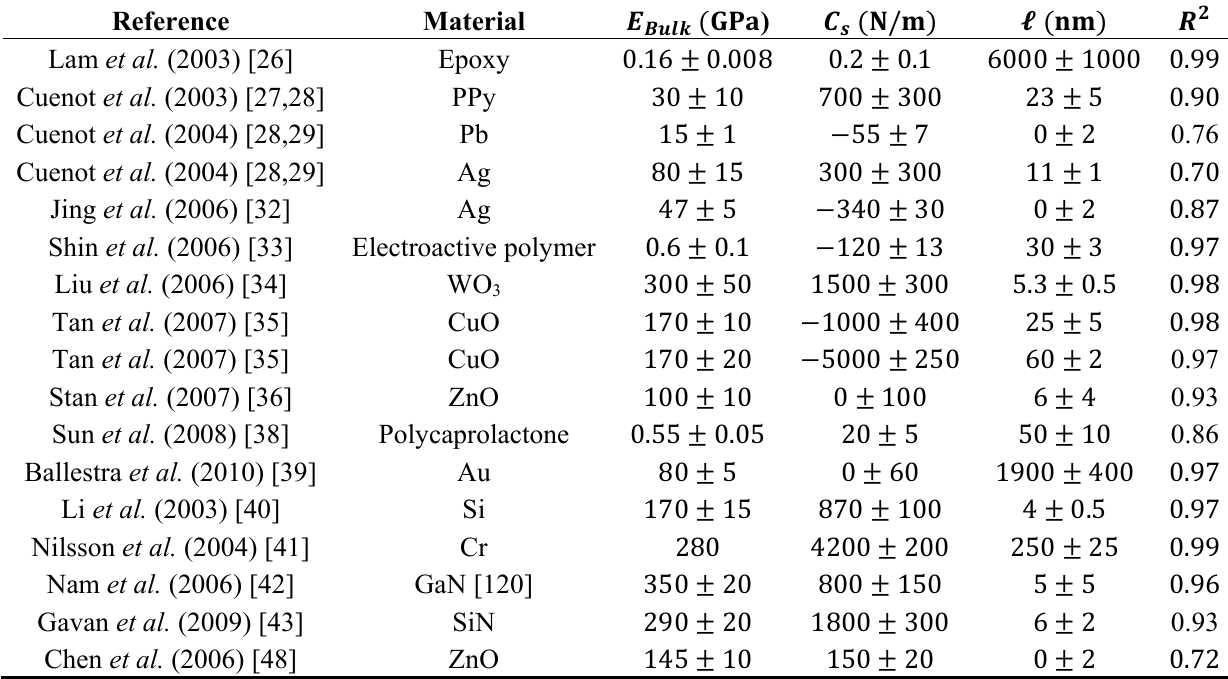
Table 2. Summary of fitting results of experimental data to combined model (Equation (23) or equivalent depending of the cross